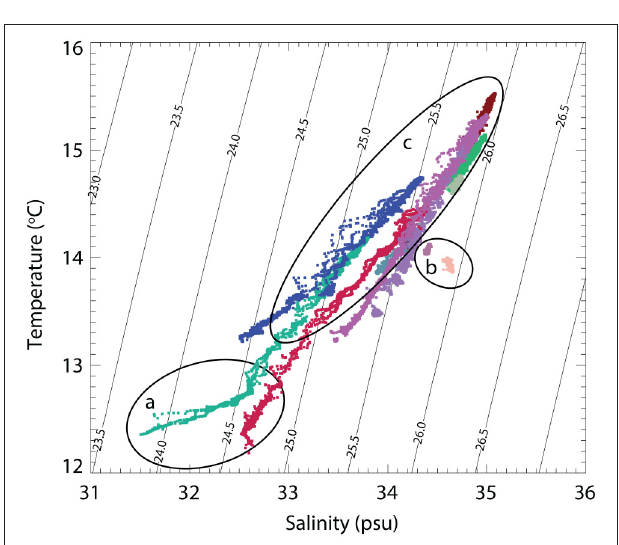
FIGURE 9 | Temperature-salinity diagram of all scamp profiles from the Firth during June 2012. T-S properties were grouped into (a) ROFI water, (b) ambient coastal water, and (c) Sandspit channel